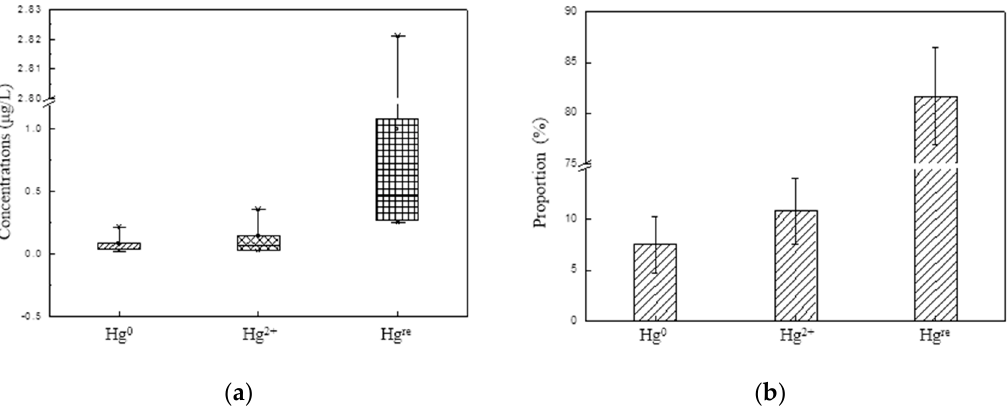
Figure 2. Distribution of Hg in different valence states: ( a ) Concentrations of Hg 0 , Hg 2+ and Hg re , and ( b ) proportions of Hg 0 , Hg 2+ and Hg re .